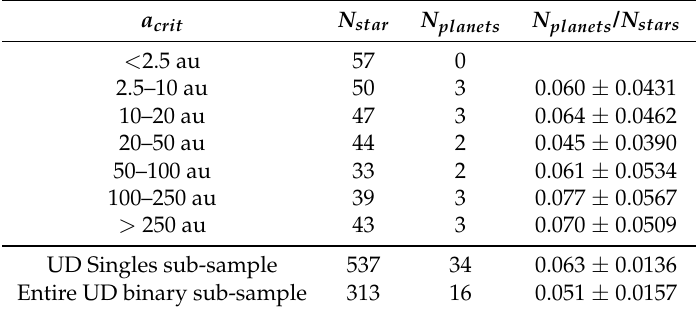
Table 2. Frequency of planets in binaries with different values of a crit